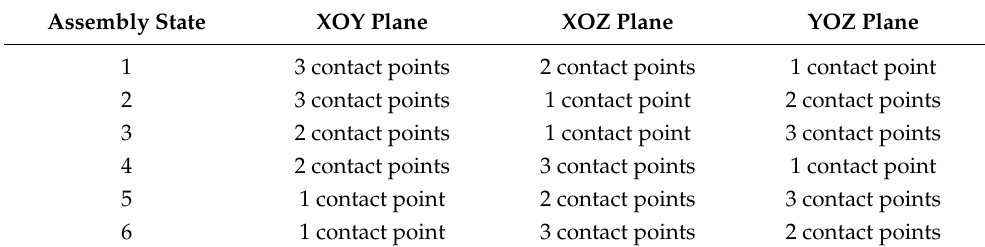
Table 1. Assembly states of the assembly with three mating planes.